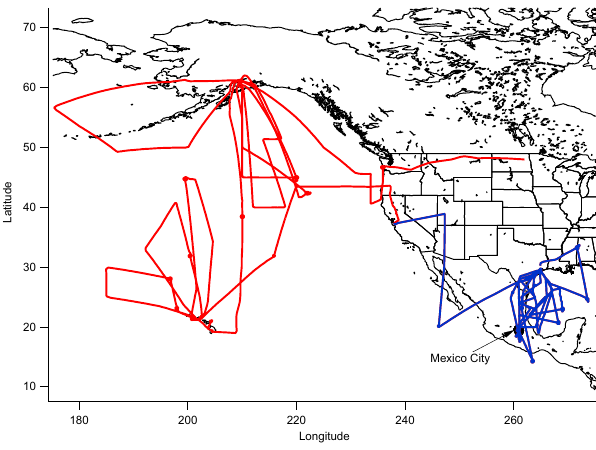
Fig. 1. DC-8 flight tracks during the INTEX-B first mission phase (blue) and second mission phase (red) on the hydrocarbon time